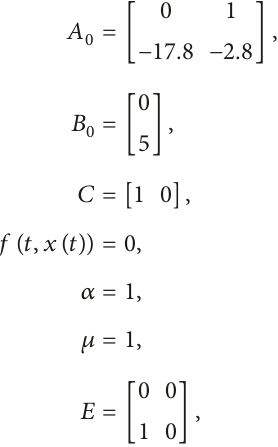
T (𝑡), ̇𝑞 T (𝑡)] T . Then, (52) and (53) can 𝑘,𝑗